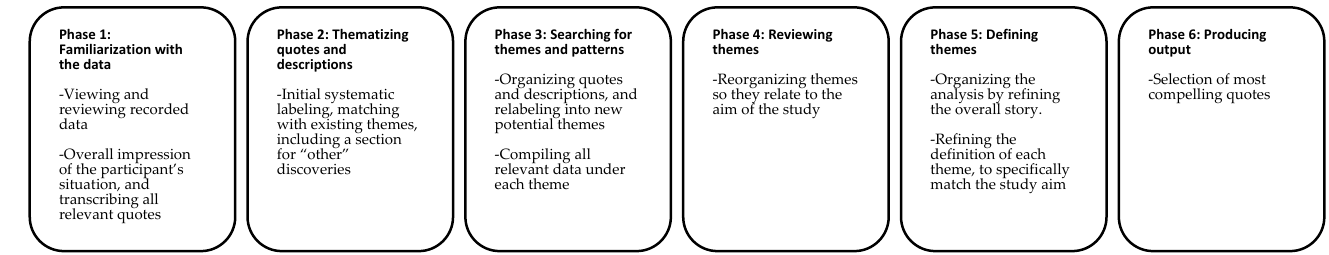
Figure 1. Overview of the phases conducted in the thematic analysis. Guidelines and adaptation from [26].